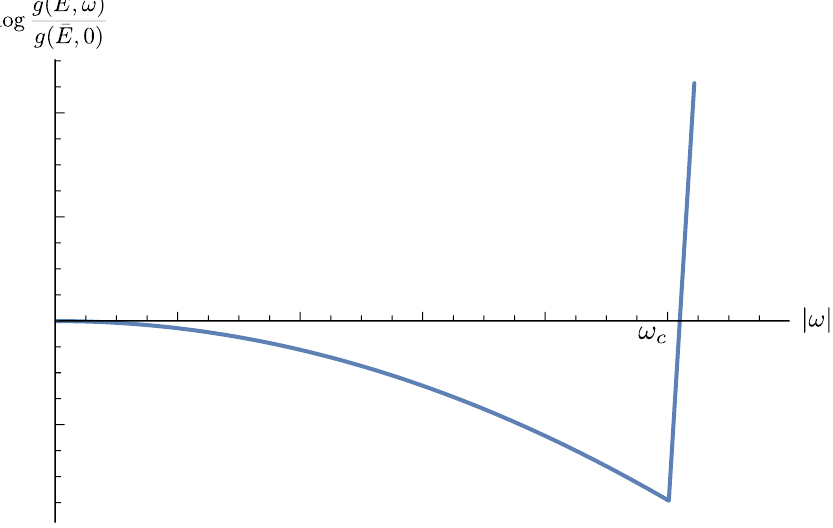
Figure 3 . The numerical value of the envelope function as a function of the energy difference | ω | for the thin shell operator in d = 2 . In this case the critical value is ω c = Gm 2 ∼ m , independent of ¯ E